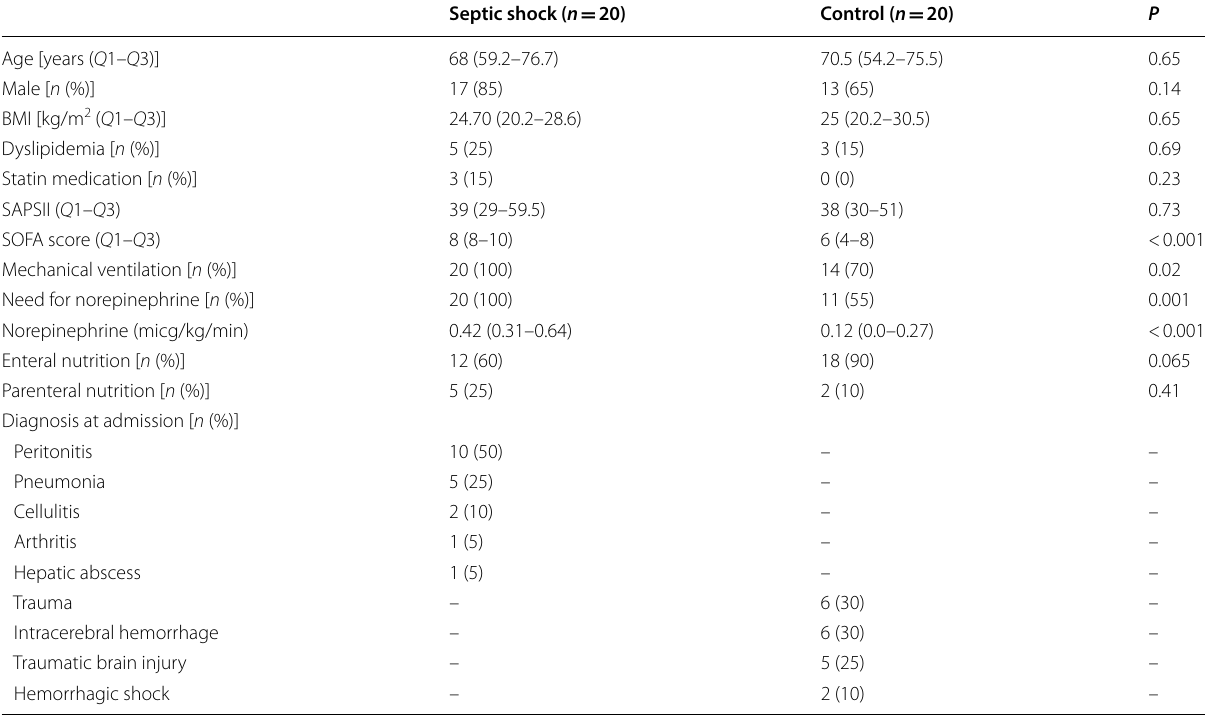
Results are expressed as medians (IQR). Between-group differences were analyzed by a Mann–Whitney test, and a Chi-square